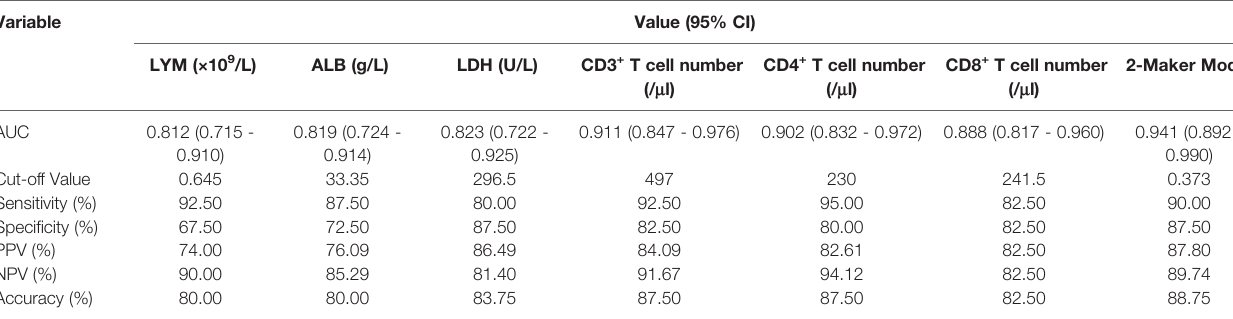
TABLE 5 | Performance of indicators and model in predicting infection of PJP.